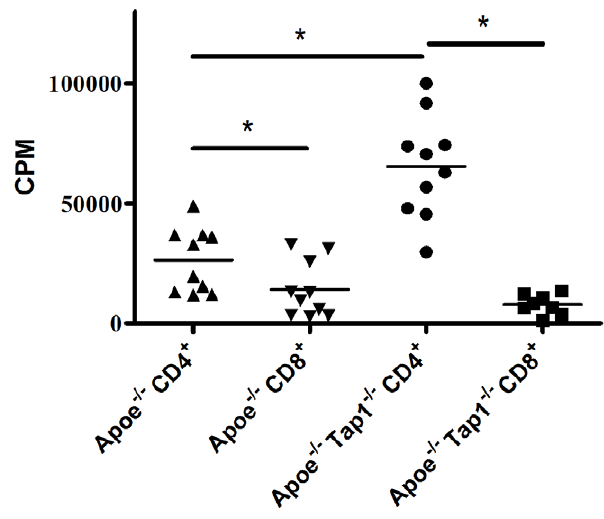
Figure 5. Proliferation of splenic CD4 + and CD8 + co-cultures of young mice. Proliferation were analysed in ConA stimulated (90 hrs) CD4 + :CD11c + (CD4 + ) and CD8 + :CD11c + (CD8 + ) cell co-cultures in Apoe 2 / 2 and Apoe 2 / 2 Tap1 2 / 2 mice with presence of radioactive labelled thymidine during the last 16–20 hrs. The cells were isolated from spleens of mice given high fat diet for 8 weeks and magnetically separated into CD11c + , CD4 + and CD8 + cells. CPM denotes counts per minute. Each dot in the figure represents one mouse. * P ,